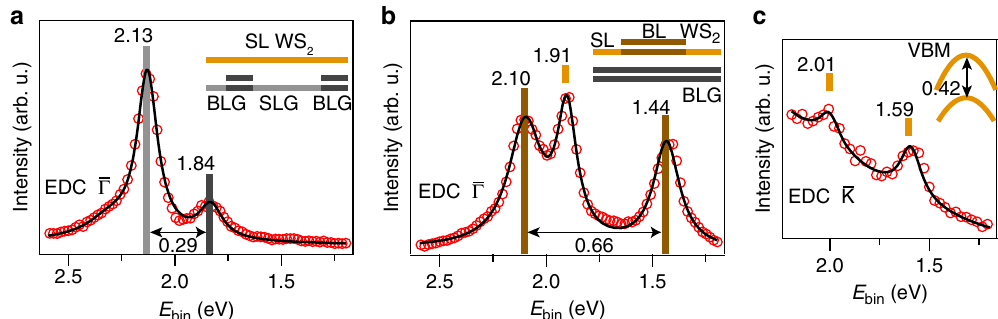
Fig. 4 Analysis of band alignments. a , b Energy distribution curves (EDCs, red circles) binned within ±0.1 Å − 1 around the (cid:1) Γ -point in the dispersions in Fig. 1e, f, respectively. The analysis is carried out a on a SL WS 2 island straddling SLG and BLG patches, and b on mixed SL and bilayer WS 2 supported on BLG (see side views in the insets). Peak positions obtained from fi ts to Lorentzian line shapes (black curves) on a constant background are given in units of electron volts. The tick marks above the peaks have been colored according to the structural diagrams and the spatial region where the peak originates from. c Similar EDC analysis as in ( a , b ) but carried out at the (cid:1) K -point in the dispersion in Fig. 1f. The fi tted peak positions provide the VBM and spin – orbit splitting (see inset)